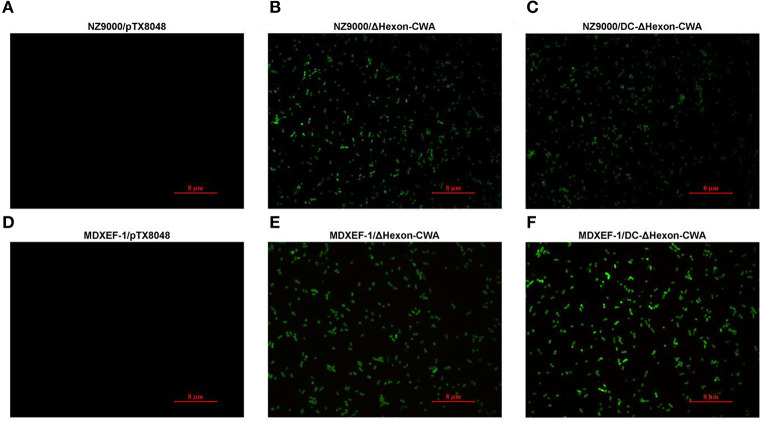
Detection of ΔHexon protein expressed on the surface of recombinant Lactococcus lactis NZ9000 and Enterococcus faecalis MDXEF-1 by indirect immunofluorescence assay (IFA). The recombinant L. lactis and E. faecalis induced by 5 ng/mL nisin (Sigma-Aldrich) were washed and centrifuged. The pellets were incubated with rabbit polyclonal antisera against ΔHexon, then reacted with goat anti-rabbit IgG conjugated to fluorescein isothiocyanate (FITC). The fluorescence on the surface of recombinant bacteria NZ9000/ΔHexon-CWA and MDXEF-1/ΔHexon-CWA (B,E), NZ9000/DC-ΔHexon-CWA and MDXEF-1/DC-ΔHexon-CWA (C,F) were observed. Recombinant bacteria NZ9000/pTX80488 (31) (A) and MDXEF-1/pTX8048 (25) (D) were used as negative controls.